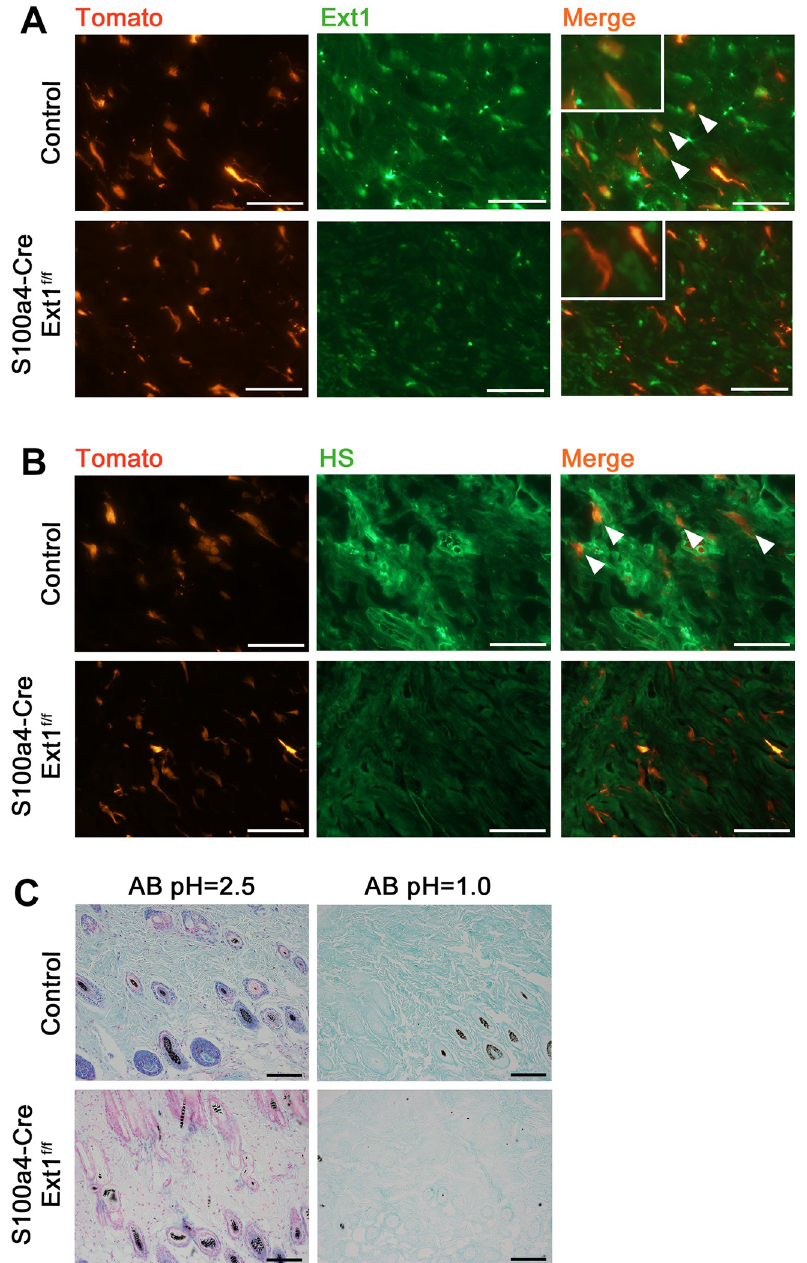
Fig 1. Loss of exostosin-1 (EXT1), specific reduction of heparan sulfate (HS) in fibroblasts, and decreased acidic mucosubstances in the stroma of S100a4-Cre; Ext1 f/f mice. (A) Immunostaining of Ext1 in subcutaneous tissues of skin of S100a4-Cre; Ext1 f/f ; Lsl-tdTomato and control ( S100a4-Cre; Lsl-tdTomato ) mice. White arrowheads indicate Ext1-positive fibroblasts. Scale bar = 50 μ m. (B) Immunostaining of HS in subcutaneous tissues of skin of S100a4-Cre; Ext1 f/f ; Lsl-tdTomato and control ( S100a4-Cre; Lsl-tdTomato ) mice. White arrowheads indicate HS-positive fibroblasts. Scale bar = 50 μ m. (C) Alcian blue staining (pH = 2.5 and 1.0) in subcutaneous tissues of skin of S100a4-Cre; Ext1 f/f and control (Ext1 f/f ) mice. Scale bar = 100 μ